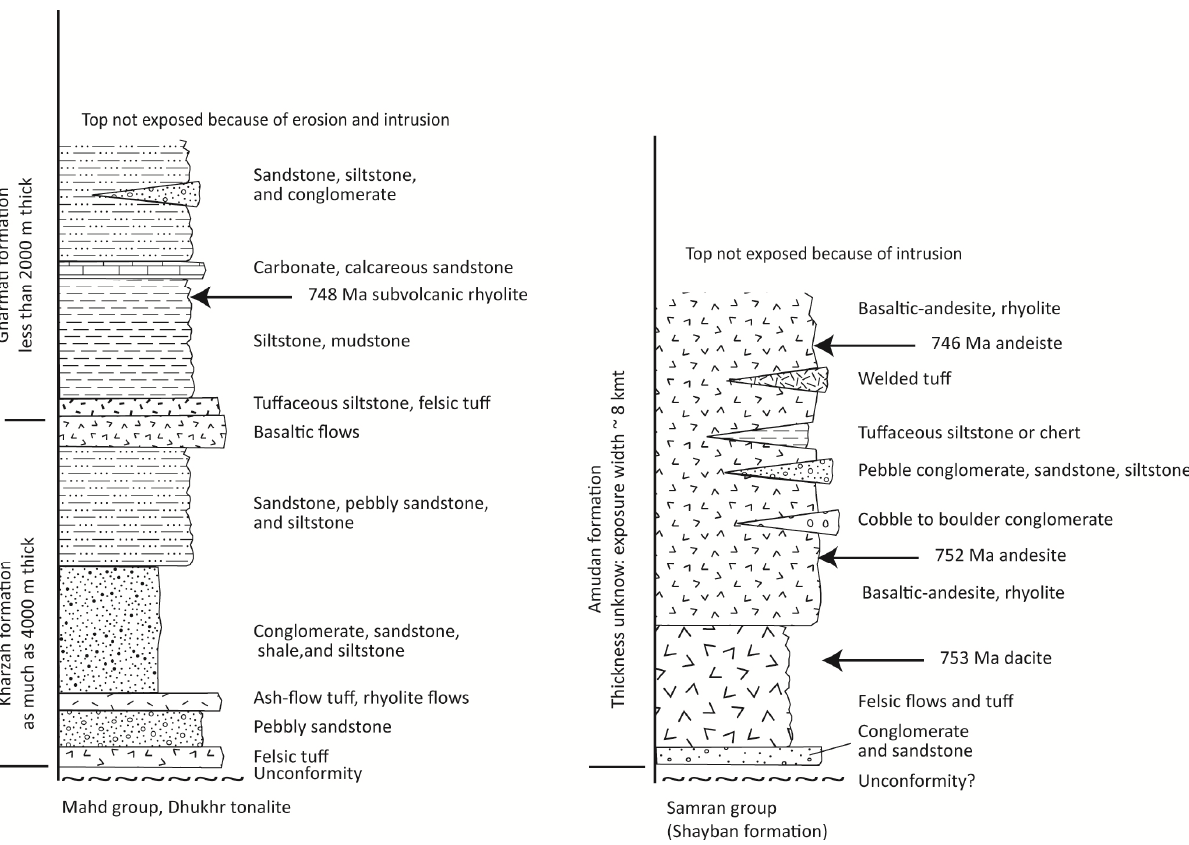
Figure 6. Representative stratigraphic columns for the Ghamr group and Amudan formation. Ghamr column after [24]; Amudan column after [25,27]. The thickness of neither column has been accurately measured. Arrows indicate the results of age dating although the exact stratigraphic positions of the dated samples are unknown; they are arbitrarily plotted here for descriptive purposes